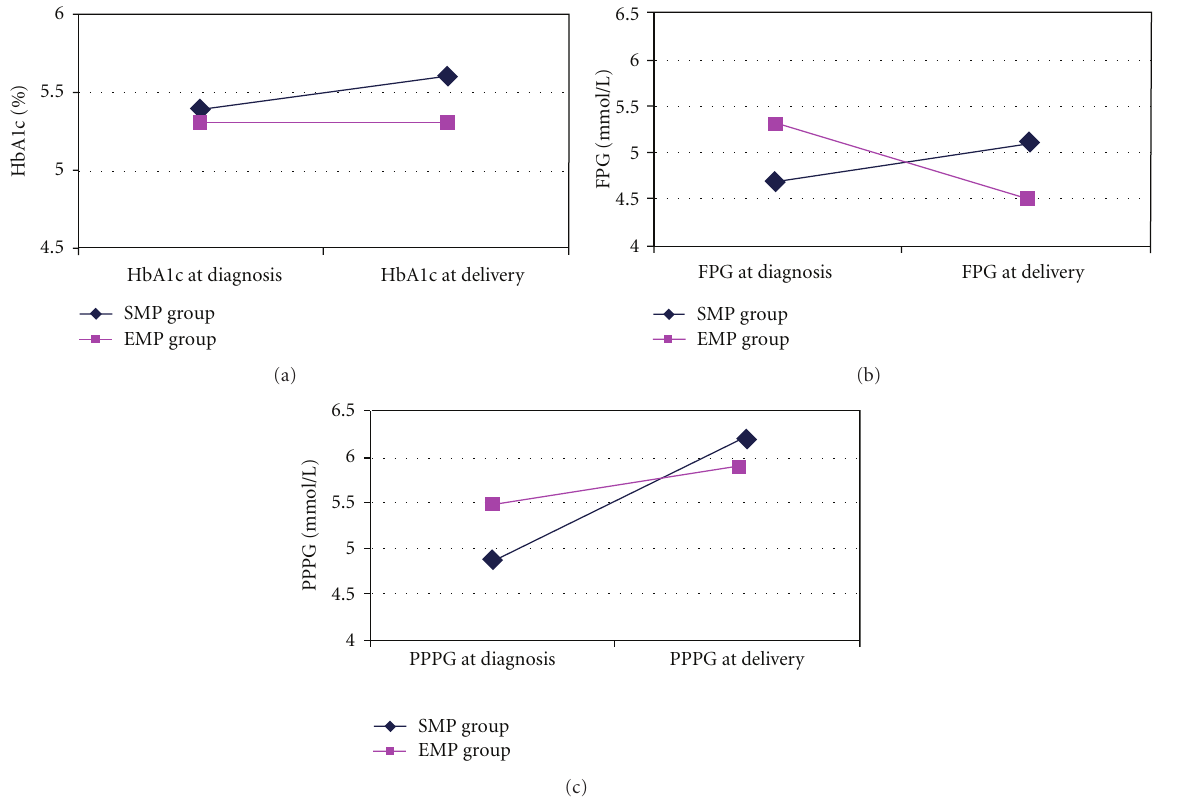
Figure 2: Metabolic parameters ((a) HbA1c; (b) FPG; (c) PPPG) evaluated in the subjects under study, AMP group: standard meal plan; EMP group: ethic meal plan; FPG: fasting plasma glucose; PPPG: 1-hour postprandial plasma